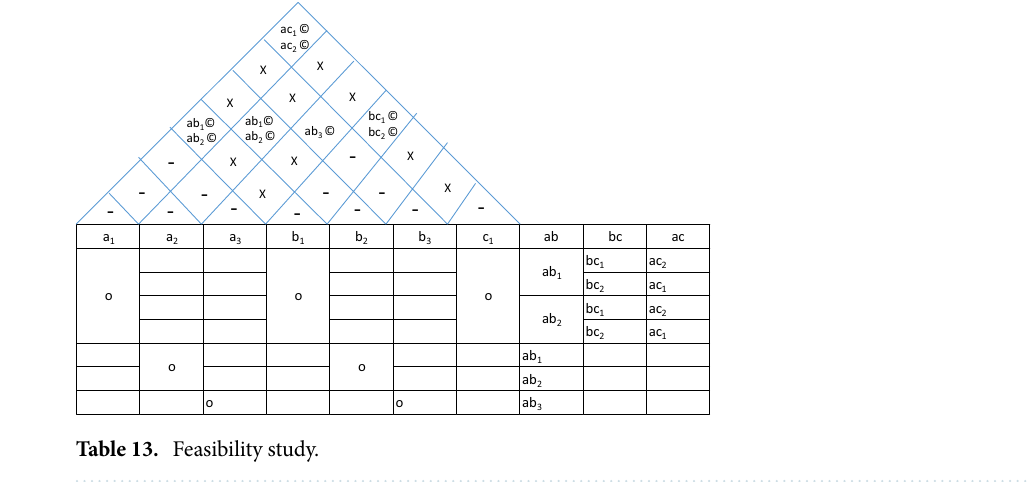
Table 13. Feasibility study.